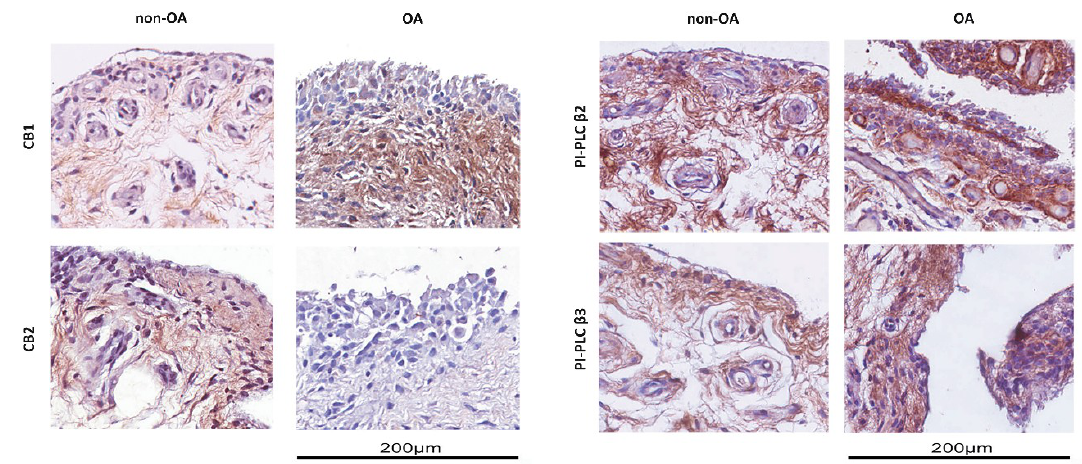
Figure 1. Immunohistochemical analysis of synovial membranes from OA (osteoarthritis) and non-OA patients. Left panel: Slices were stained with anti-CB1 and anti-CB2 receptor antibodies. Right panel: Slices were stained with anti-PI-PLC β 2 and anti-PI-PLC β 3 antibodies. Slides were counterstained with hematoxylin and mounted with permanent mounting media. This figure shows representative images of different experiments (n = 5 non-OA and n = 6 OA).